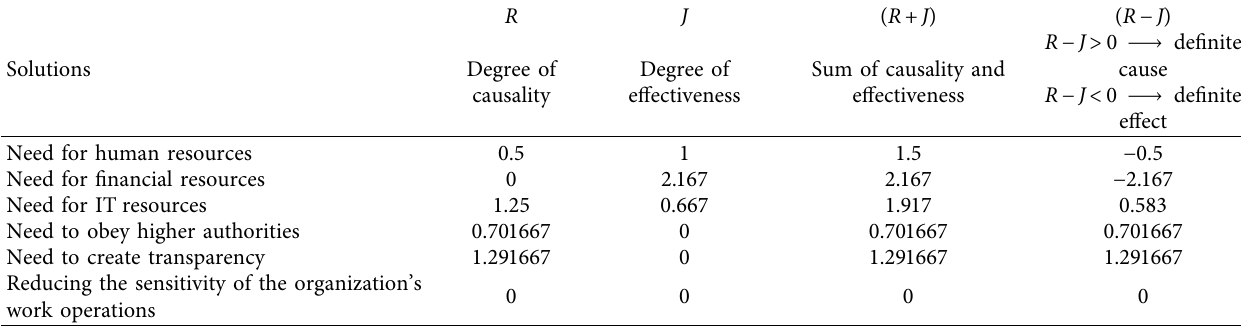
Table 2: The degree of causality and effectiveness between the solutions.